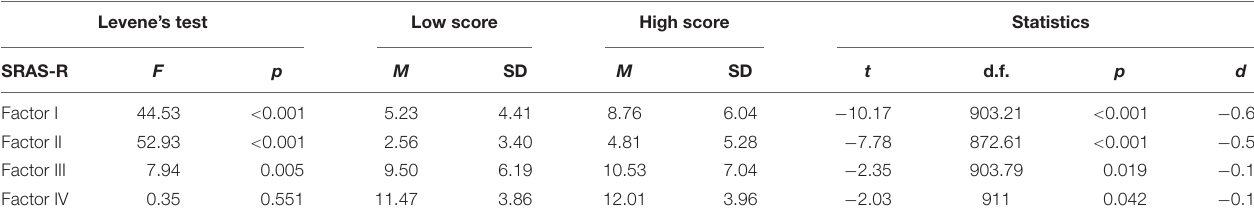
TABLE 4 | Differences in school refusal behavior in students with high and low scores on Anger.